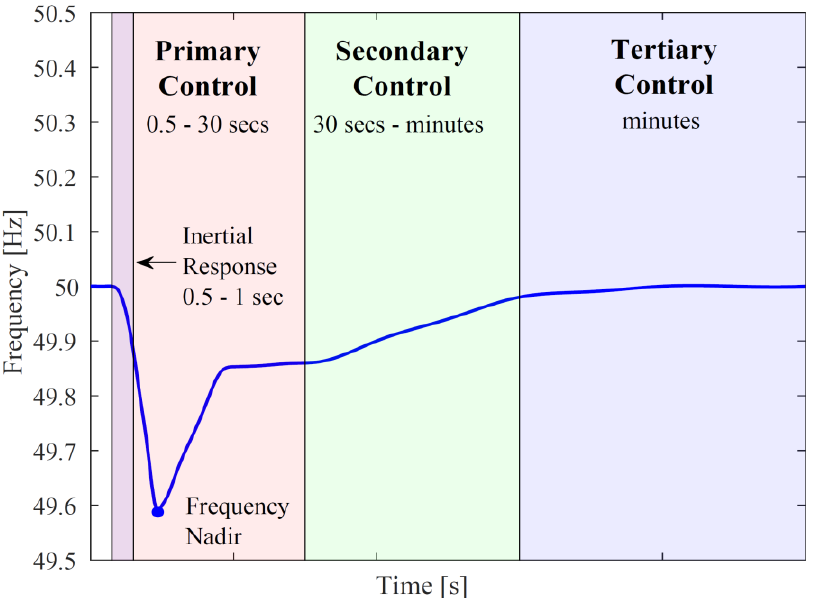
Figure 5. Primary, secondary, and tertiary frequency control responses.